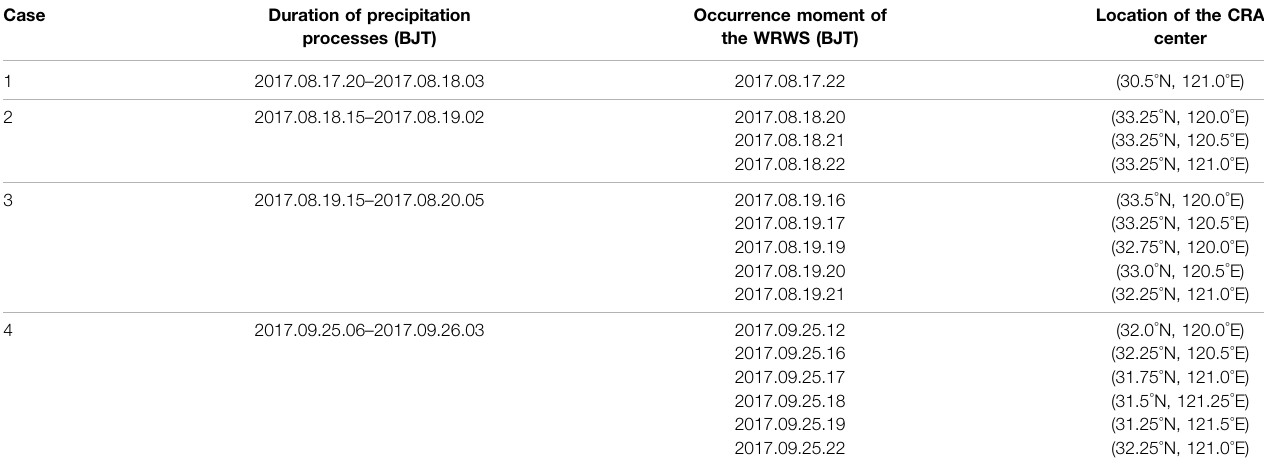
Occurrence moment of the WRWS (BJT)